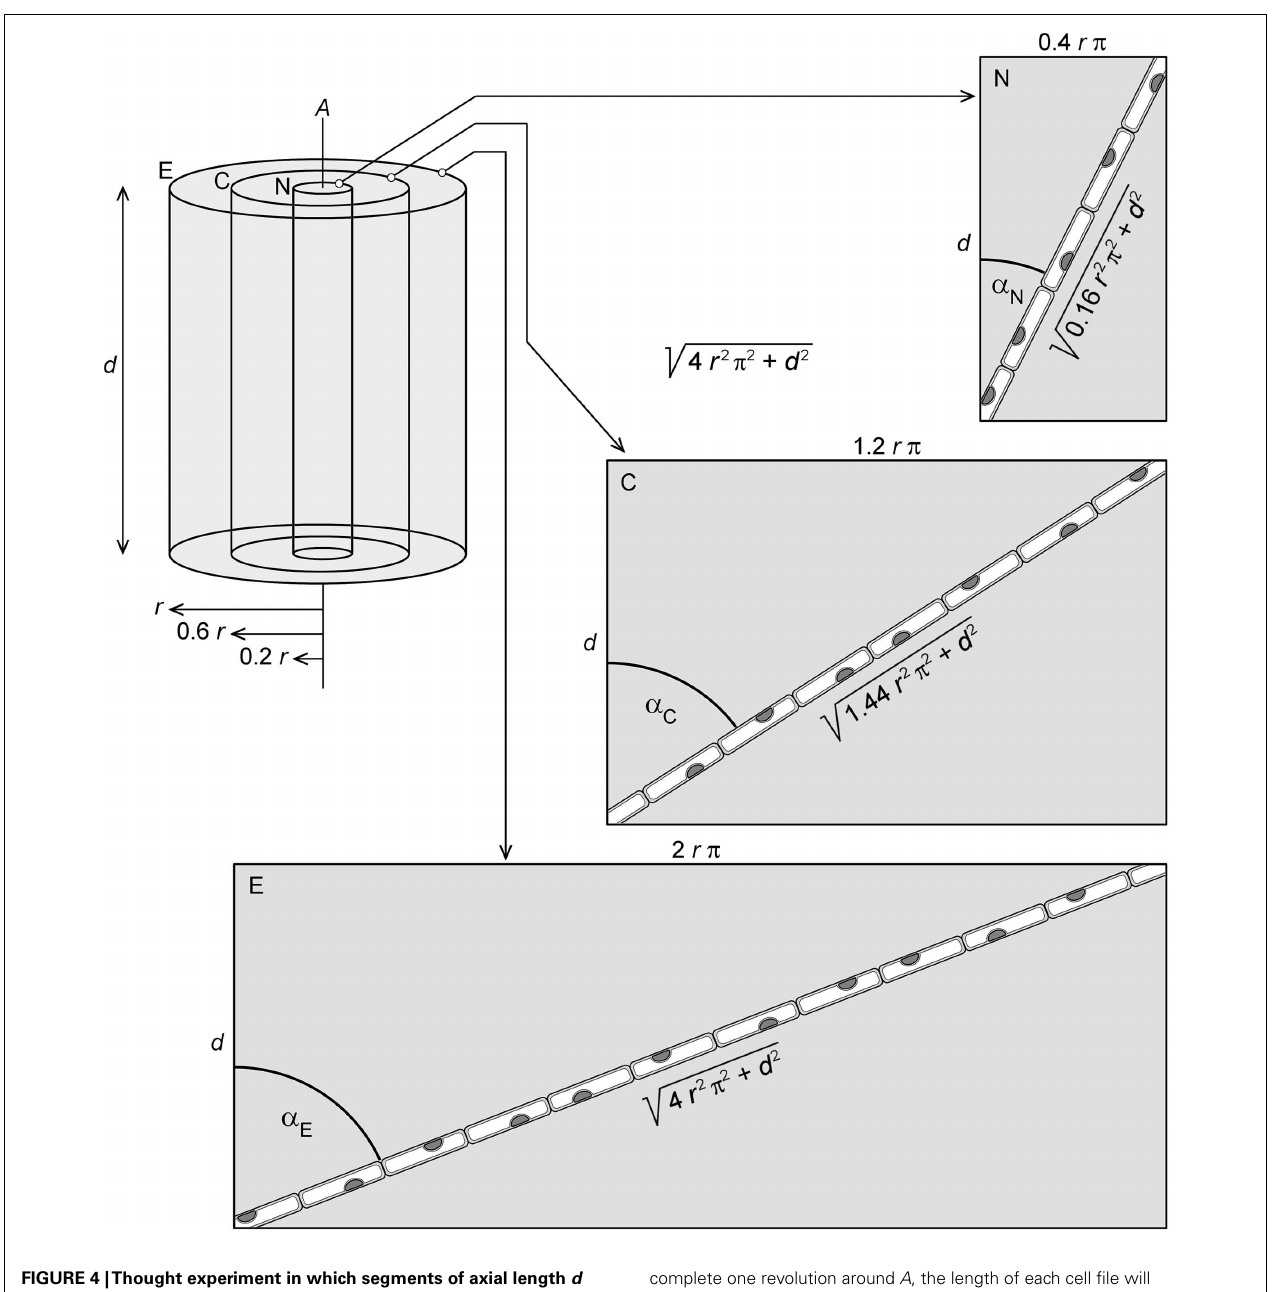
FIGURE 4 |Thought experiment in which segments of axial length d of three cell layers of different radii (E, epidermis of radius r ; C, cortex of radius 0.6 r ; N, endodermis of radius 0.2 r ) are isolated from a twisted-organ and cut open to form rectangles. If d is chosen to equal the distance along the organ axis ( A ) that the cell files require to